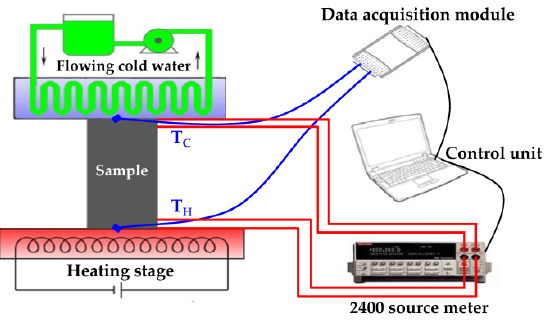
Figure 1. The schematic of self-made equipment for measuring properties of as-prepared samples. The σ was given by using the equation σ = IL/VS, where L, S are the length and cross-sectional area of samples. The α was defined as α = ∆ V/ ∆ T, where ∆ V, ∆ T are the open circuit voltages and temperature difference of two sides. ∆ T = T H − T C , where T H and T C are the hot-side and cold-side temperature. The P was calculated by using the equation P = VI. The V, ∆ V and I were measured by the Source Meter instrument (SMI, Keithley 2400). The hot-side temperature (T H ) and cold-side temperature (T C ) were recorded by a data-acquisition module, as shown in Figure 1. During σ measurements, the T H and T C were fixed, and the SMI instrument was set to different workloads to measure the I and V. It was evaluated by using the two outer thermocouples for temperature (T) measurement and the inner electrodes for open circuit voltages ( ∆ V) measurement. During α